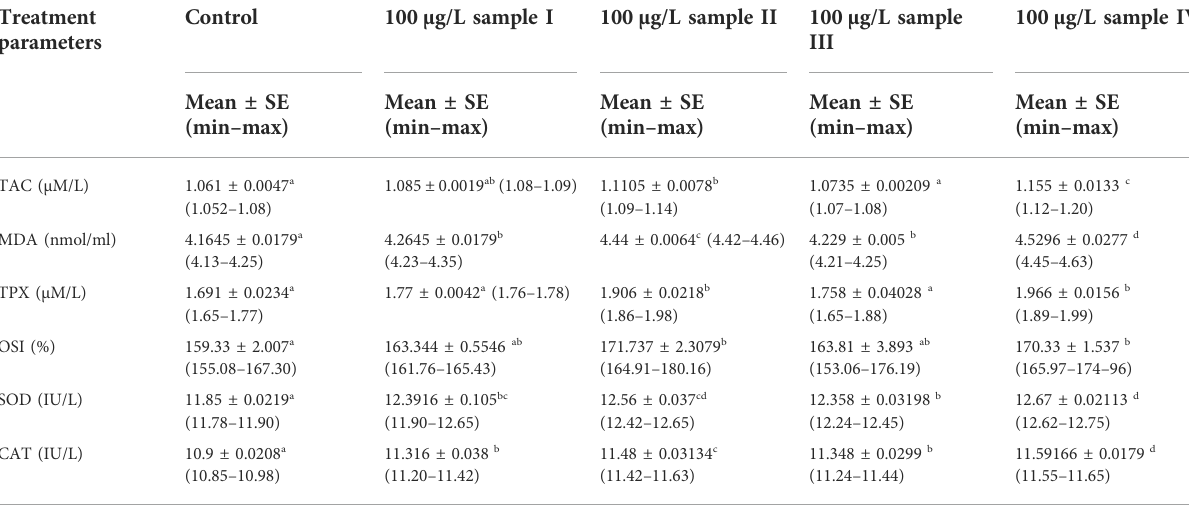
TABLE 4 Effects of alkaline rock powder exposure for 15 days on the antioxidant parameters of the juveniles of Tilapia ( Oreochromis niloticus ). Treatment